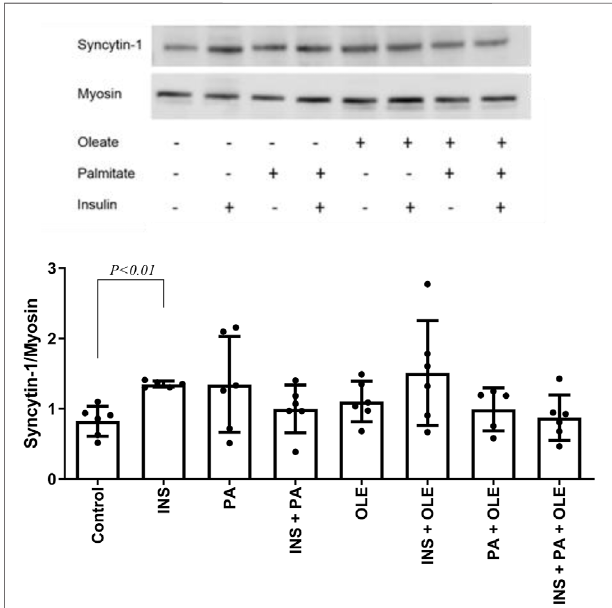
FIGURE 2 | Western blot analysis of syncytin-A expression in differentiated C2C12 myotubes treated with either insulin (INS; 20 nM), palmitate (PA; 300 uM), oleate (OLE; 300 uM), or their combinations, and compared with the no treatment condition (i.e., control). Individual data points are depicted along with mean ±